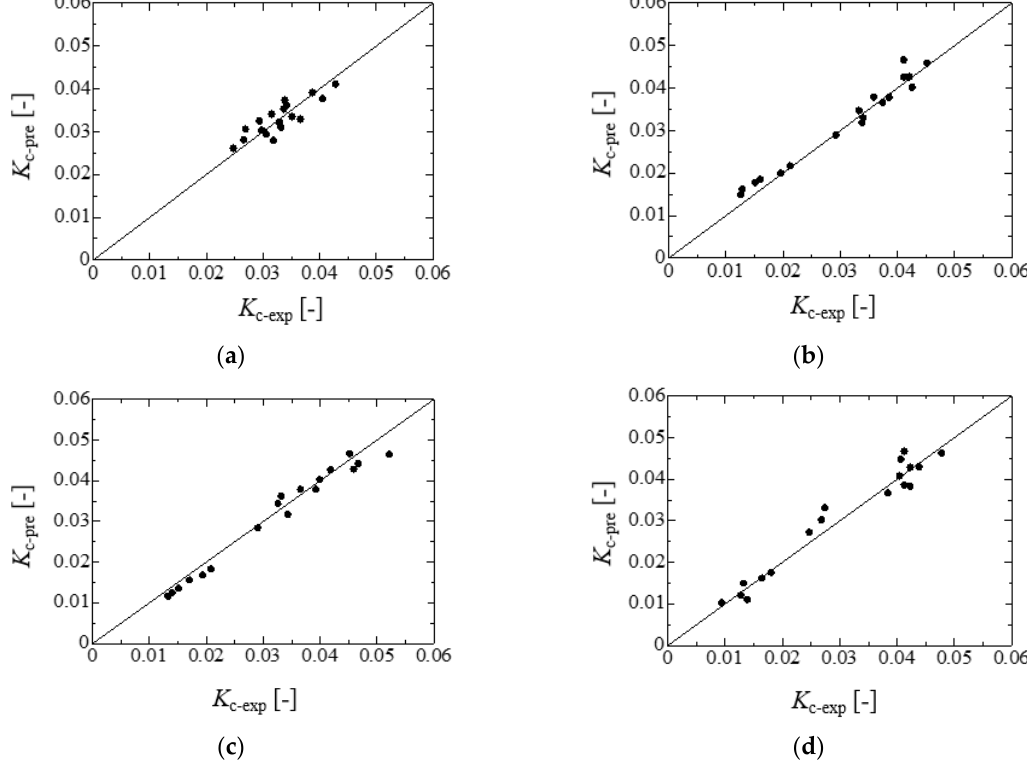
Figure 8. Comparison of K c-exp with K c-pre : ( a ) bare substrate; ( b ) #400 substrate; ( c ) #240 substrate; and ( d ) #120 substrate. K c-exp and K c-pre are evaluated by Equation (2) and Equation (5), respectively.